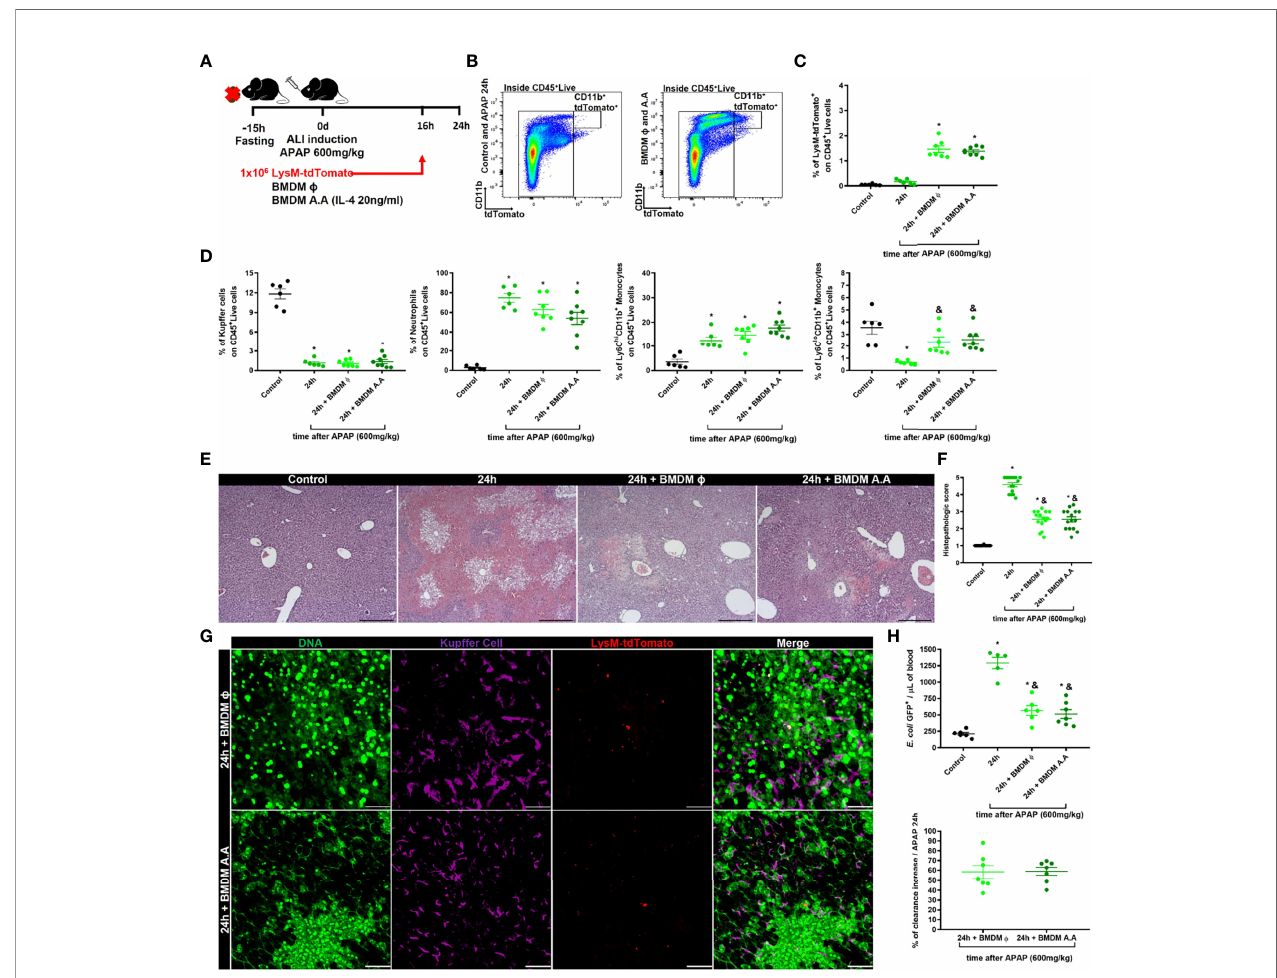
FIGURE 8 | Cellular therapy with bone marrow-derived macrophages reduce liver necrosis and rescues liver blood clearance. (A) Scheme for bone marrow-derived macrophage (BMDM) therapy during ALI, 16h after APAP administration. 1x10 6 BMDC from LysM cre/+ Rosa26 tdTomato/+ mice that were non-activated (BMDM f ) or alternatively activated with IL-4 (BMDM A.A) were transferred into recipient mice 16h after APAP administration. (B) Flow cytometry gate strategy of inoculated LysM cre/+ Rosa26 tdTomato/+ BMDM f and BMDM A.A in CD45+ live cell gate detected in the liver 8h after BMDM therapy (24h post-APAP administration). (C) Percentage of LysM cre/+ Rosa26 tdTomato/+ in liver samples; n ≥ 5 mice; representative of 2 independent experiments. (D) Evaluation of myeloid cell niche after BMDM cell therapy by fl ow cytometry showing the percentage (%) of myeloid cell subtypes; n ≥ 5 mice; representative of 2 independent experiments. (E) Representative liver histopathology of all four groups stained with Hematoxylin and Eosin (H&E); scale bar = 500 µm. (F) Tissue damage measured by the histopathologic score of the liver; n = 8-15 mice per group. (G) Representative IVM images of treated groups (BMDM A.A and BMDM f ) showing extracellular DNA (green, Sytox green), Kupffer cell (purple, anti-F4/80), and LysM cre/+ Rosa26 tdTomato/+ (red); scale bar = 100 µm; n = 2 mice per group. (H) Measurement of liver fi rewall function by quanti fi cation of E. coli GFP + events per ul of blood (Upper panel) by Flow cytometry and determination of the blood clearance ability (Bottom panel; % increase over the APAP at 24h) 5 minutes after infection with 5x10 6 bacteria/20g; n ≥ 5 mice per group; Representative of 2 independent experiments. Data are presented as mean ± SEM. * indicates statistical difference compared to the control group using one-way ANOVA followed and Tukey post-test (* = p < 0.05). & indicates statistical difference compared to the 24h group (not treated with BMDM) using one-way ANOVA followed and Tukey post-test (& = p <